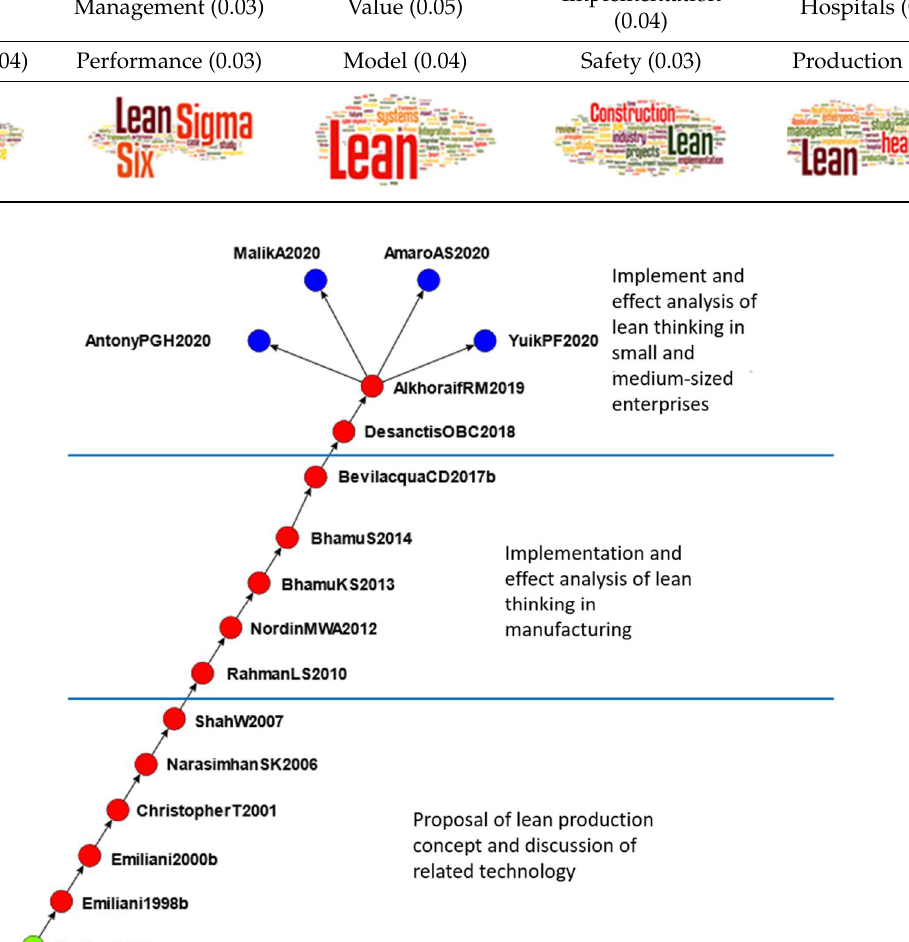
Figure 6. The main path of the first group.